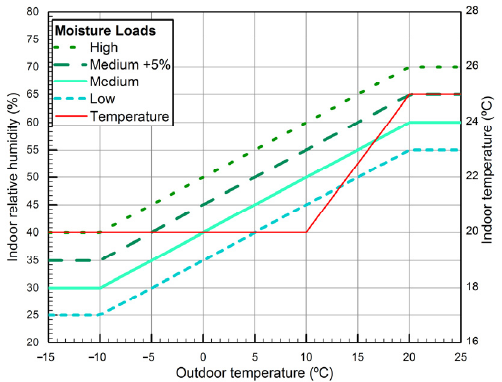
Figure 7. Derived room air temperature and humidity of living spaces as a function of the outside air temperature according to the WTA 6-2. temperature according to the WTA